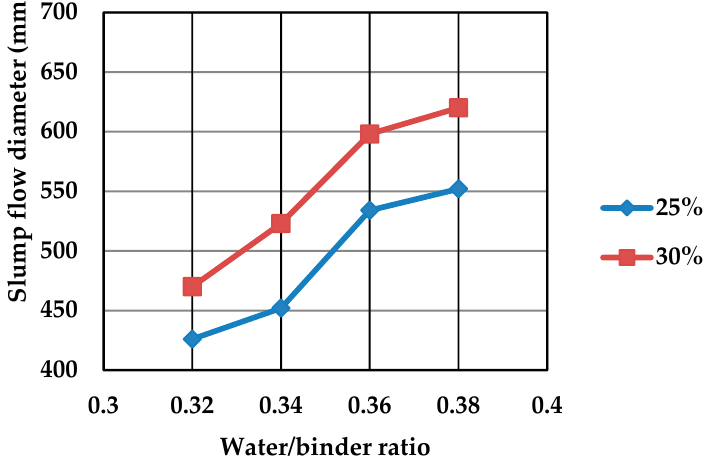
Figure 2. Slump flow variations at different fly ash proportions w.r.t w/b ratios.